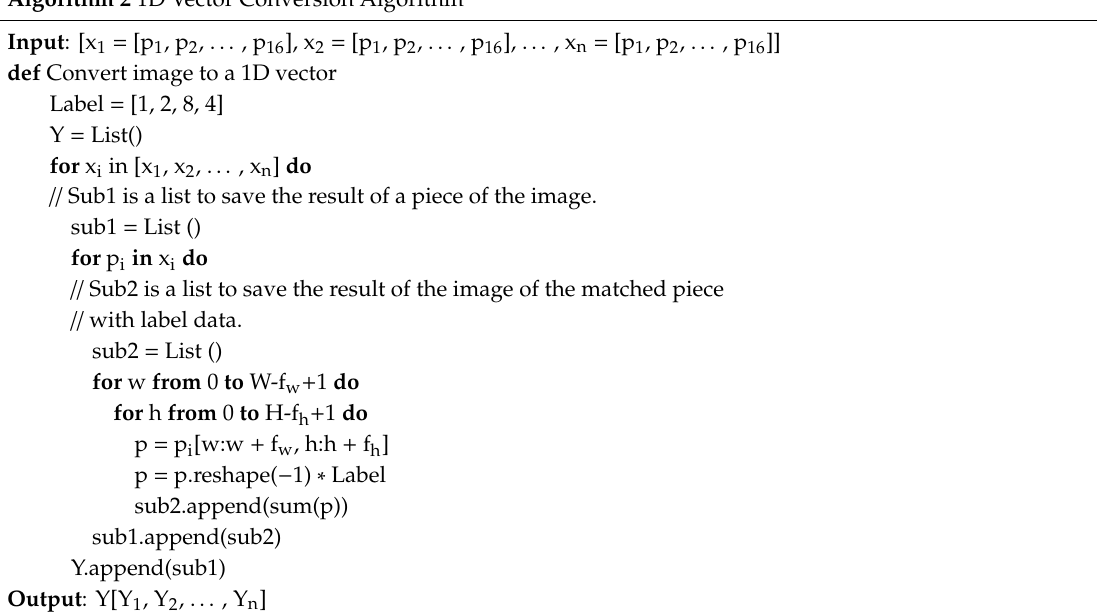
Algorithm 2 1D Vector Conversion